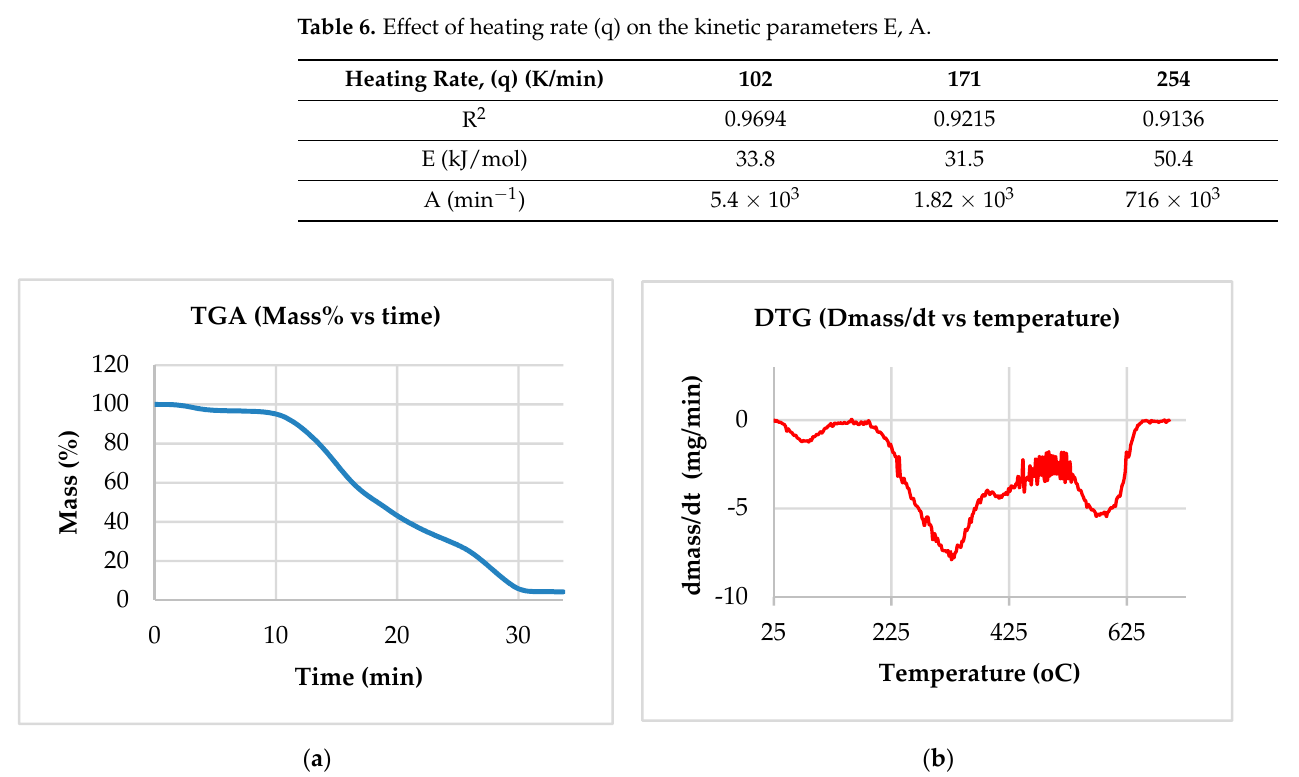
Figure 6. ( a ) Pyrolytic biochar weight loss diagram as a function of time (TGA, Air flow). ( b ) Biochar weight change rate diagram as a function of temperature (DTG, Air flow).